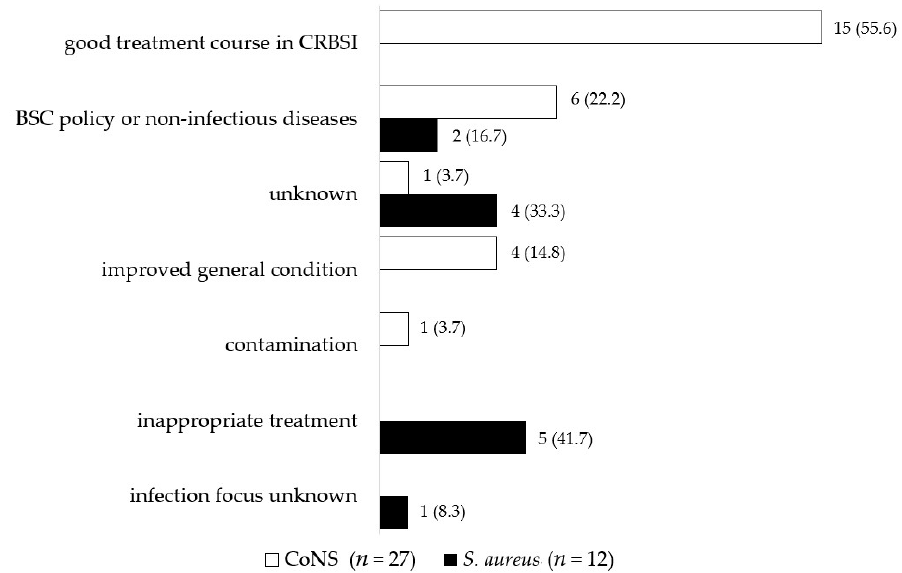
Figure 1. Reasons for non-clearance of persistent staphylococcal bacteremia. Data are presented as numbers (%). A good treatment course for CRBSI was defined as a case of CRBSI with appropriate antimicrobial therapy, good source control, and a good clinical course (e.g., improvement in consciousness, vital signs, and general condition); therefore, negative BCs were not confirmed. The underlying diseases of patients who became part of the BSC policy were gastric cancer, interstitial pneumonia, cerebral infarction, and disseminated intravascular coagulation. Non-infectious diseases are cases in which the clearance of PB cannot be confirmed due to the death of a patient from a disease other than an infectious disease, interstitial pneumonia, or acute pancreatitis. An improved general condition means that negative BC was not confirmed due to improved general condition. Inadequate treatment refers to patients with inadequate duration of antimicrobial therapy, poor choice of regimen, or inadequate source control. Antimicrobial therapy was deemed inappropriate if at least one of the following conditions was met: administration of inefficacious antimicrobial agents, i.e., agents that did not effectively treat infections with organisms identified in the BC; continuation of the initial antimicrobial agents even though the susceptibility test result was known, and de-escalation was possible; and administration of antibiotic therapy for a shorter period than the current medical standards. BC, blood culture; BSC, best supportive care; CoNS, coagulase-negative staphylococci; CRBSI, catheter-related bloodstream infection; S. aureus , Staphylococcus aureus.